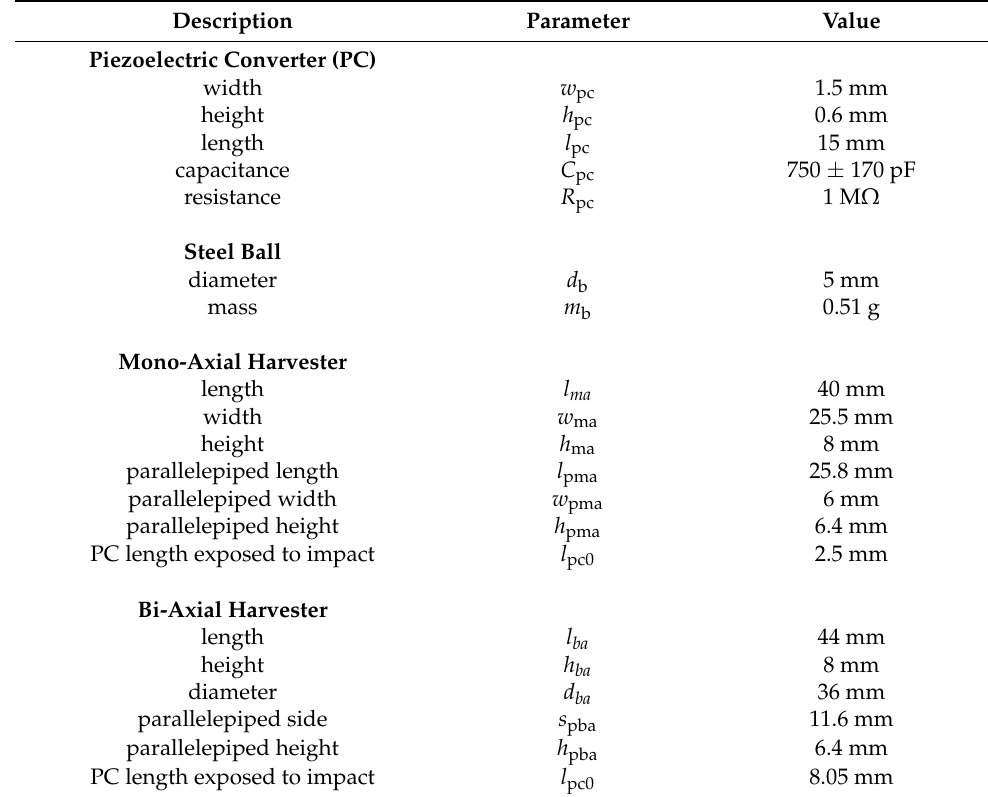
Table 1. Physical properties of the employed PCs and steel ball and geometrical dimensions of the developed mono-axial and bi-axial